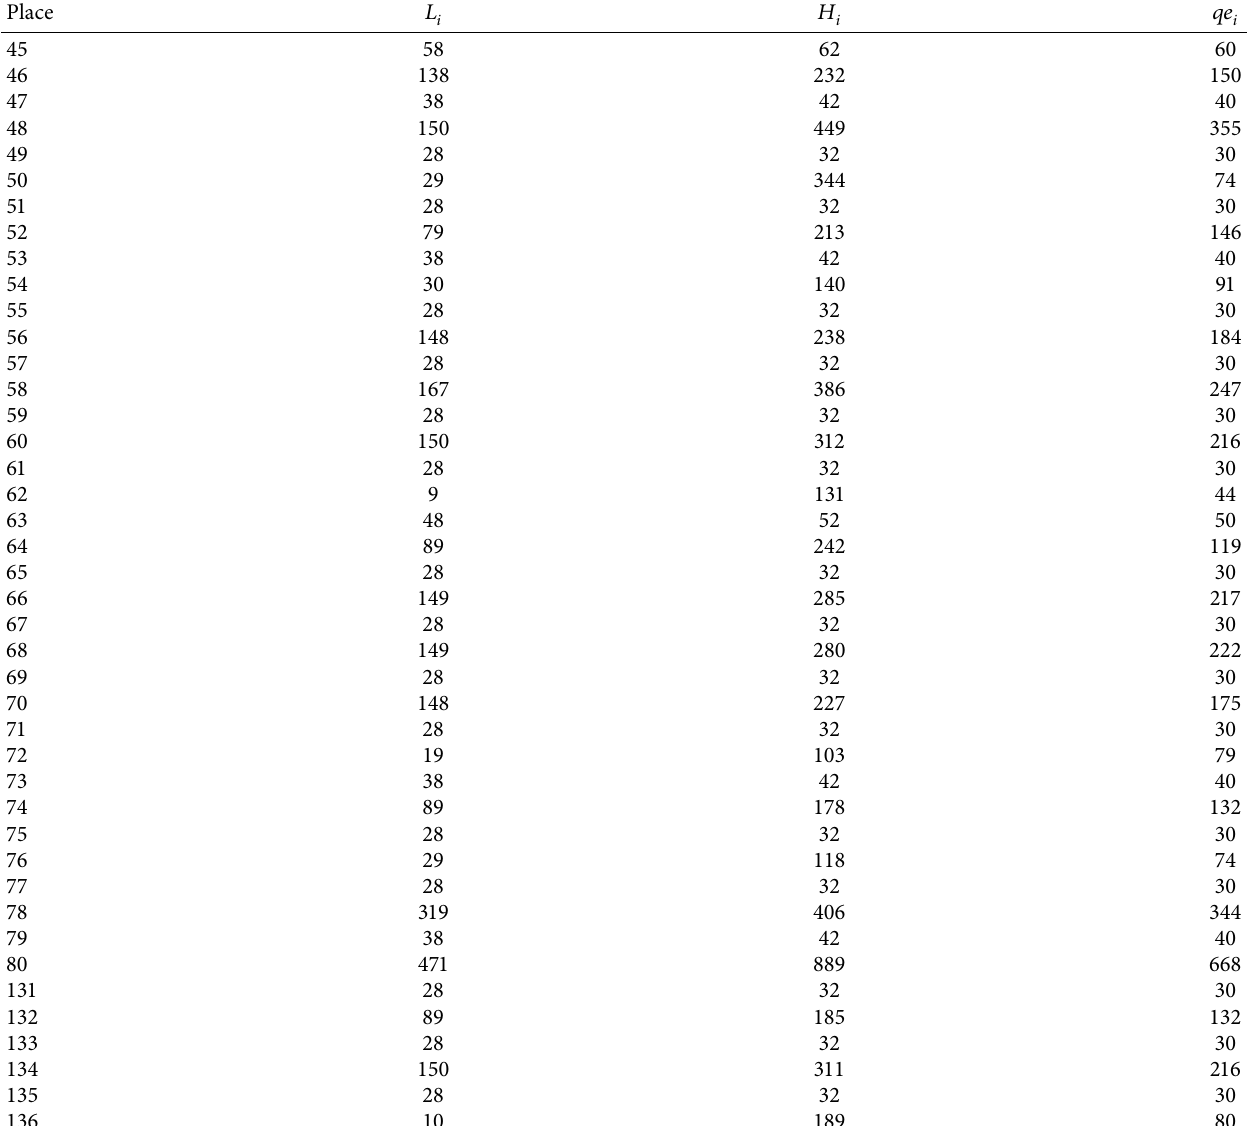
Table 2: Parking and travelling